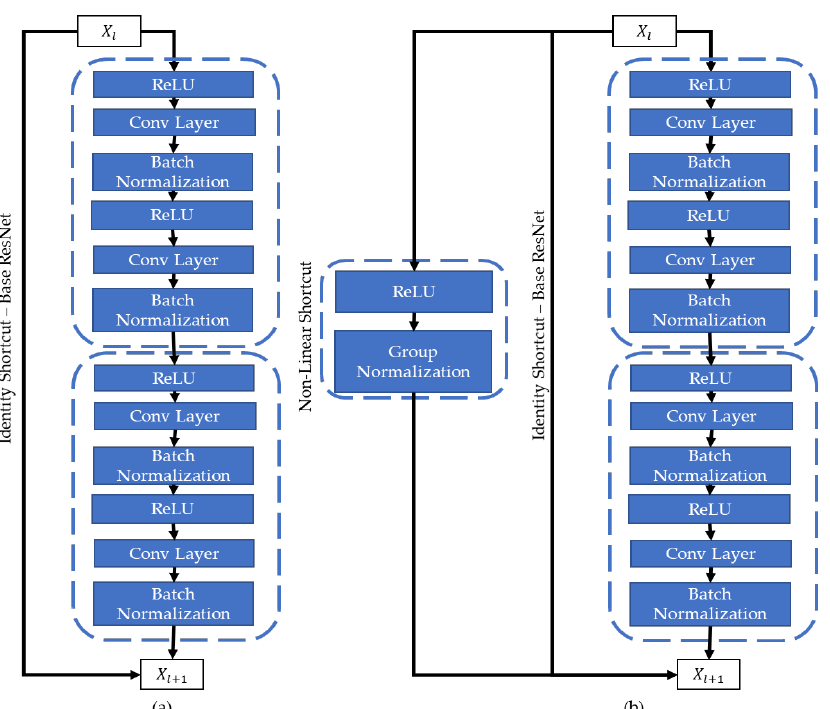
Figure 4. ( a ) ResNet with Identity shortcuts. ( b ) RGSNet (ReLU-Group Norm ResNet) with non-linear connections